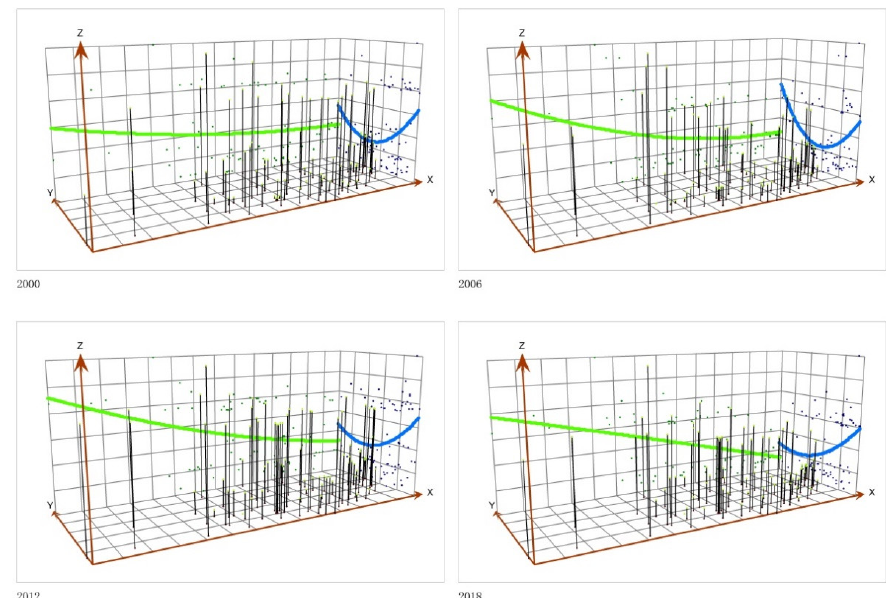
Figure 6. Trends in GUECL in the Yellow River Basin.